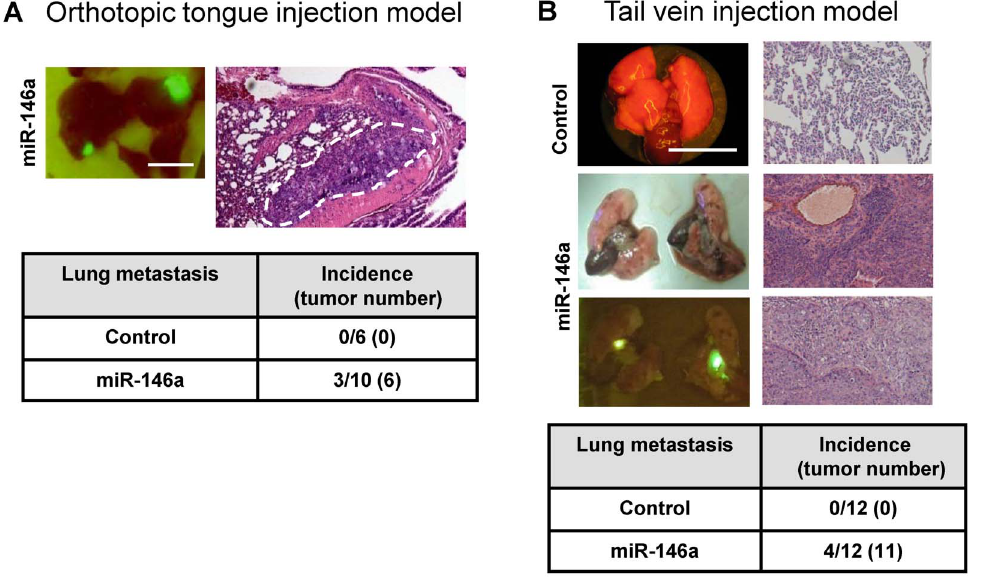
Figure 5. Association between exogenous miR-146a expression and lung metastasis in SAS cells. (A) Orthotopic tongue injection and lung metastasis model using the NOD-SCID mouse. Upper, a fluorescent image showing the distal metastatic lesions in the lungs (Lt) and in a histopathological section (Rt). The dotted line delineates the lesion. Lower, a summary of the lung metastasis. (B) Tail vein injection metastasis model. Upper Lt, representative gross and fluorescence images of lungs; Rt, representative histopathological sections of lung tissues showing un-involved lung (Upper picture) and the metastatic carcinomas (Middle and Lower pictures). Lower, a summary of the lung metastasis. Bars, 1 cm. Magnification of the histopathological sections, x100. Numbers in parentheses are tumor numbers. SAS cell subclone with exogenous miR-146a expression has a greater metastasis potential in relation to the controls.